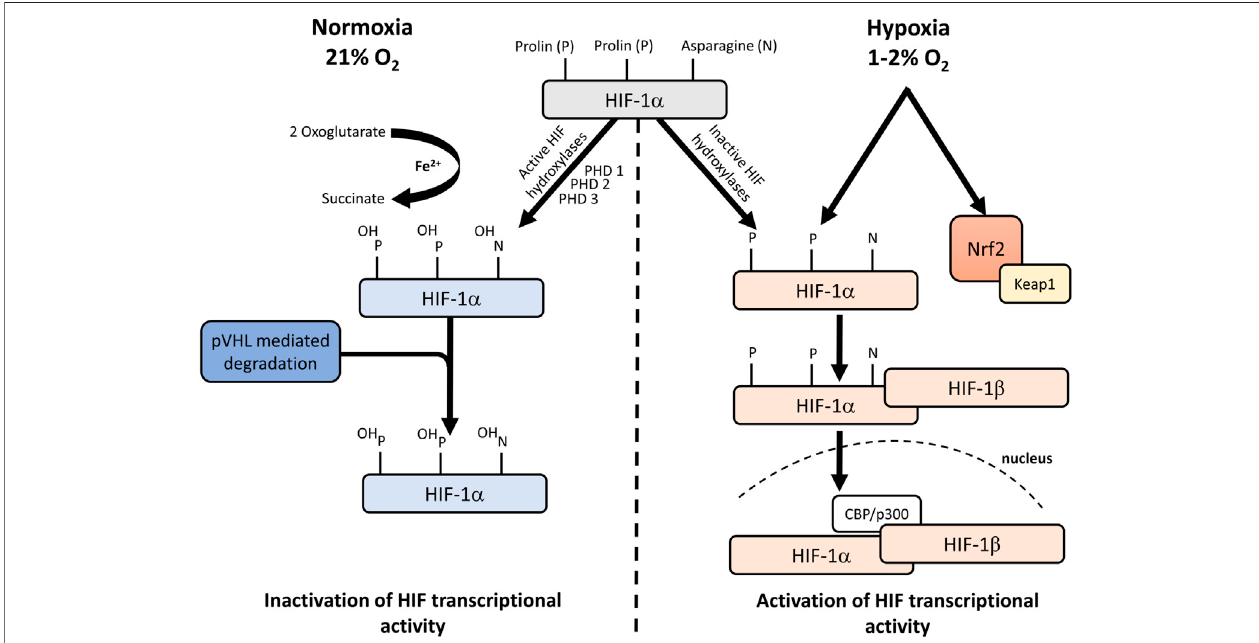
FIGURE 1 | Hypoxic regulation of HIF-1. Under normoxic conditions, NO impairs the activity of HIF-1 α prolyl hydroxylases and inhibits HIF-1 α ubiquitination and interaction with pVHL. Under hypoxic conditions, NO induces Keap1 signalling and suppresses HIF-1 α hypoxic stabilization. CH 4 increases the expression of Nrf2. HIF: hypoxia-induciblefactor;pVHL:vonHippel – Lindauprotein; Ub:ubiquitin;NO:nitrogenmonoxide;PHD:prolinhydroxylases;Keap1:kelch-likeECH-associatedprotein- 1; Nrf2: nuclear factor-erythroid factor 2-related factor 2.